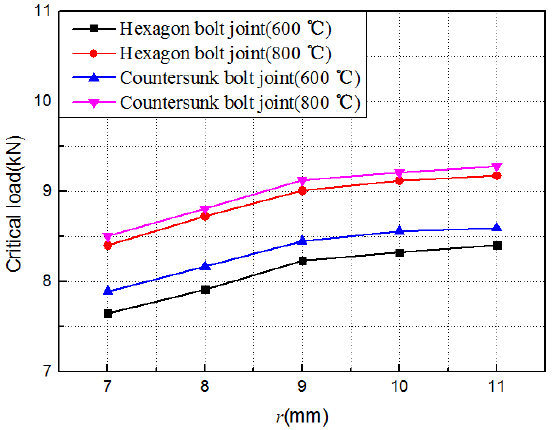
Figure 20. Evolution of the critical load with the radius of the nut r .